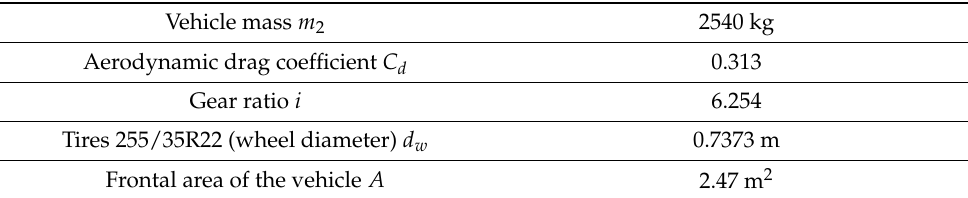
Table 2. Fisker Karma vehicle parameters